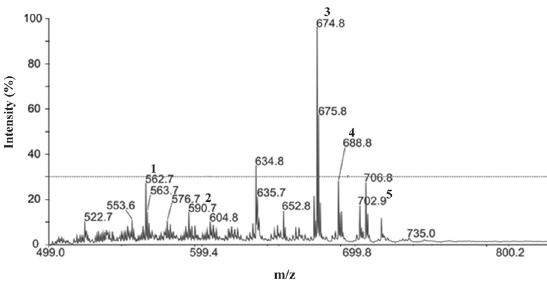
Figure 11 - Negative mode MALDI-TOF mass spectrometry analysis of GIPLs ceramide of epimastigotes of Silvio X10/1 T. cruzi strain. 1. N-palmitoylsphinganine; 2. N-stearylsphinganine; 3. N-lignoceroylsphinganine; 4. N-pentacosanoylsphinganine; 5.